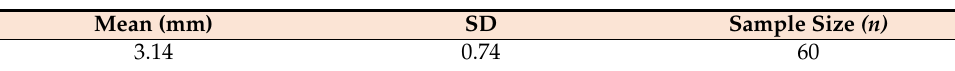
Table 2. Gingival exposure in the study group.